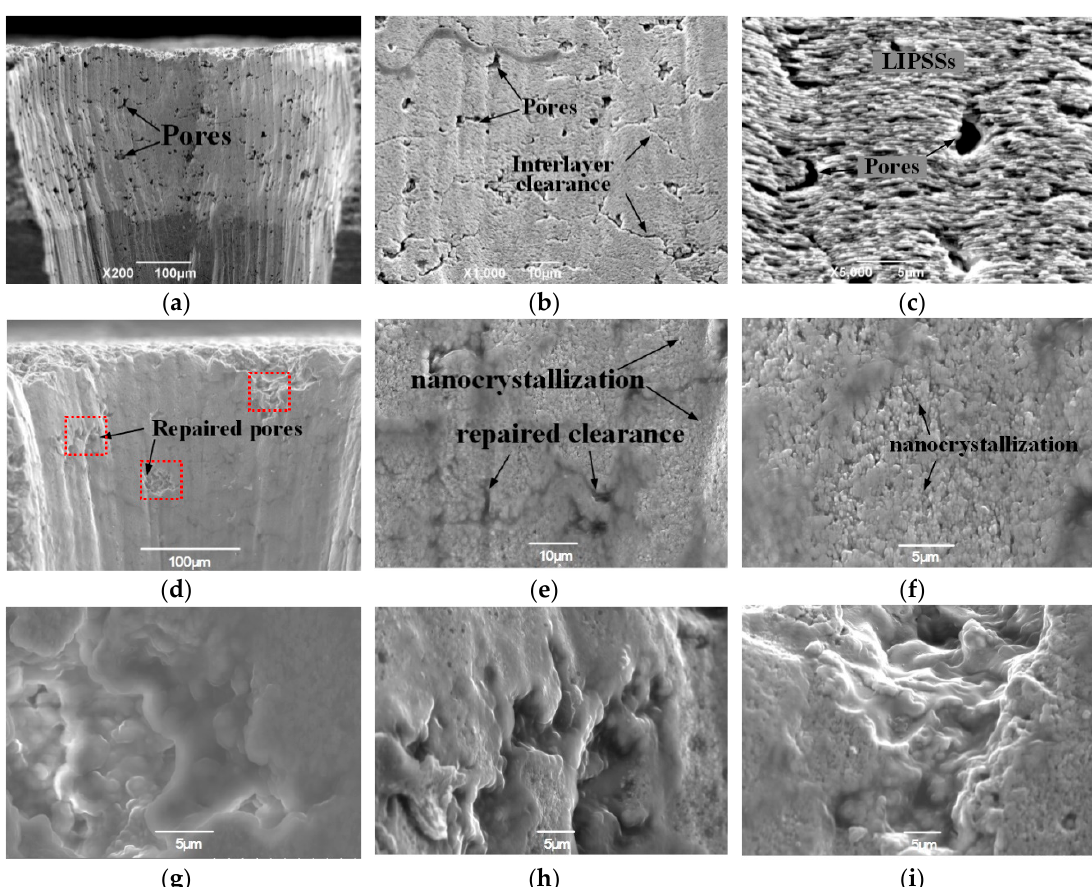
Figure 2. SEM images showing cross sections of low-frequency femtosecond (LF-fs) laser-drilled holes: ( a – c ) unrepaired, ( d – i ) repaired with high-frequency (HF)-fs laser, ( b , c ) microstructure details in ( a ), and ( e – i ) repaired details in ( d ).